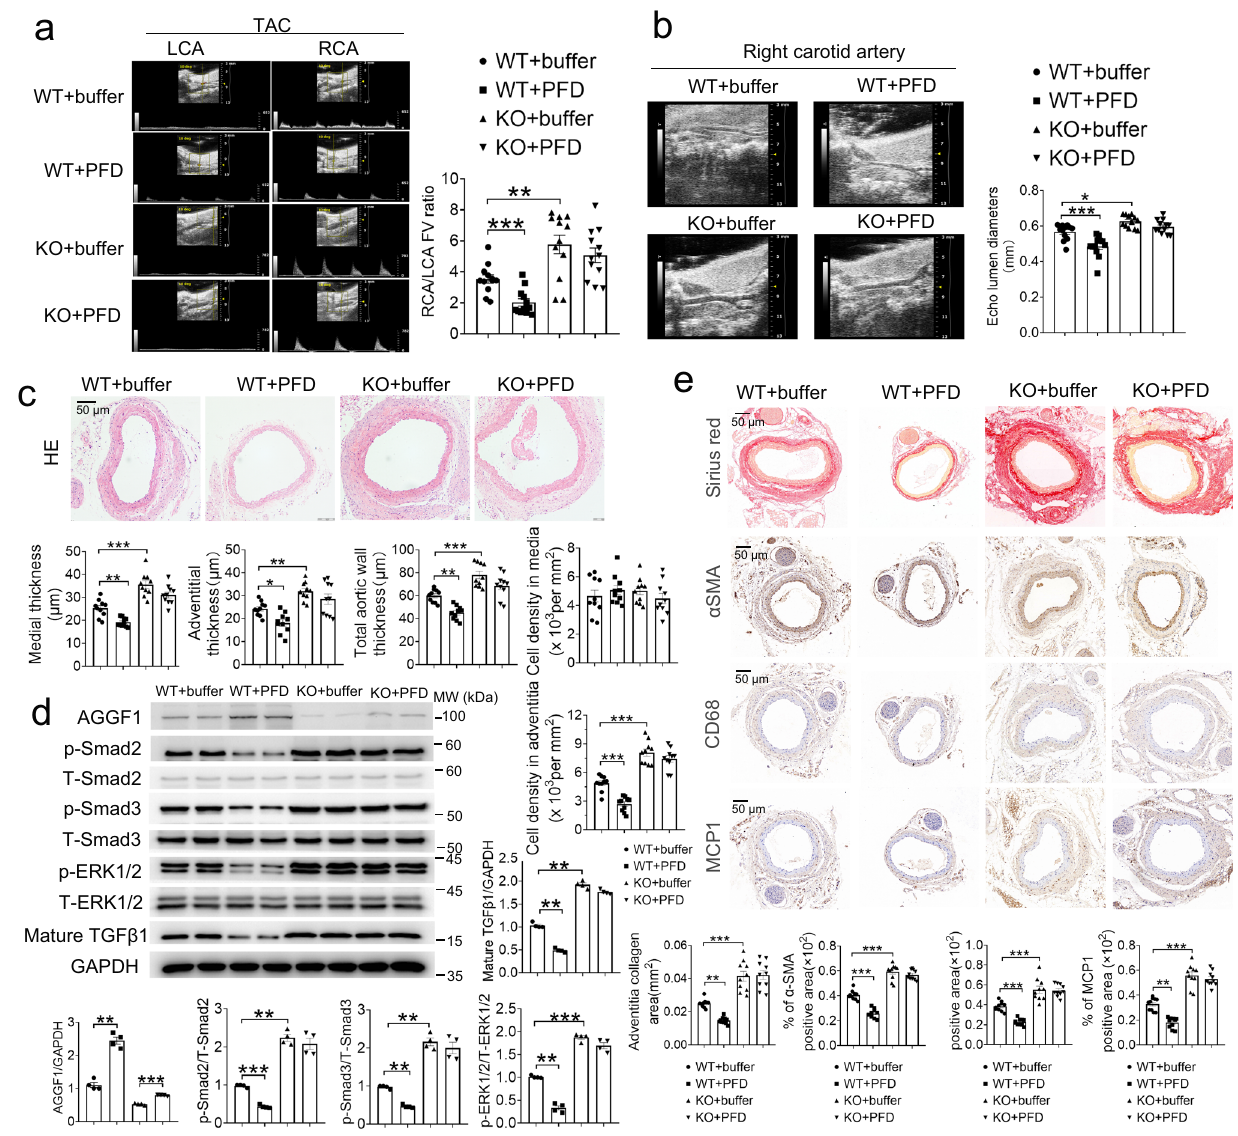
Fig.7|PirfenidoneattenuatesTAC-inducedarterialdilatation,remodelingand in fl ammation by inhibiting Smad2/3, ERK1/2 phosphorylation, and mature TGF β 1 in male Aggf1 +/+ (WT) mice, but not in male Aggf1 +/ − (KO) mice. a EchocardiographicimagesofLCAandRCAfromWTorKOmicethreeweeksafter TAC with or without pirfenidone treatment. The bar graph on the right shows the ratio of fl ow velocity (FV) of RCA over LCA ( n =12 mice/group). b Mean lumen diameterofRCA( n =12/group). c H&Estainingofcross-sectionsofRCA.Bargraphs showmedialthickness,adventitialthickness,totalaorticwallthickness,celldensity